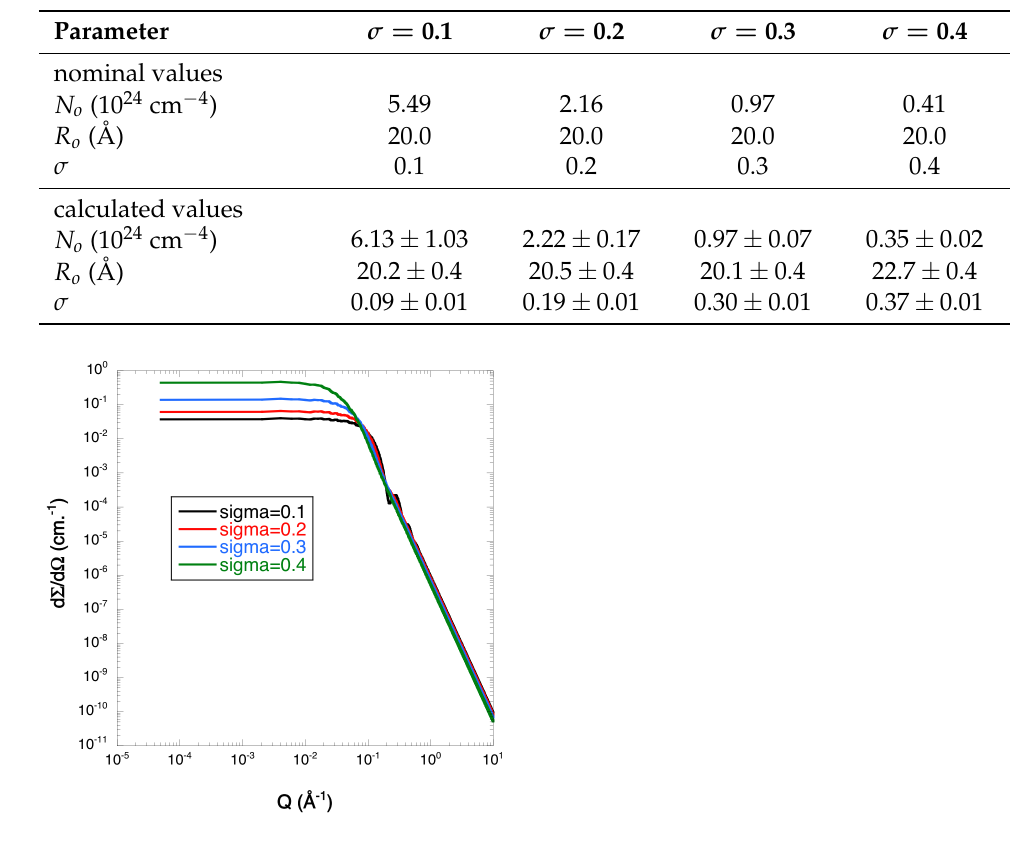
Figure 2. Simulated SCSs of a lognormal SDF of spherical inhomogeneities; N o are normalized to ensure a volume fraction of 1%; R o = 20 Å; four values of σ are considered (0.1, 0.2, 0.3, and 0.4). The Guinier and the Porod approximations are present in the investigated Q